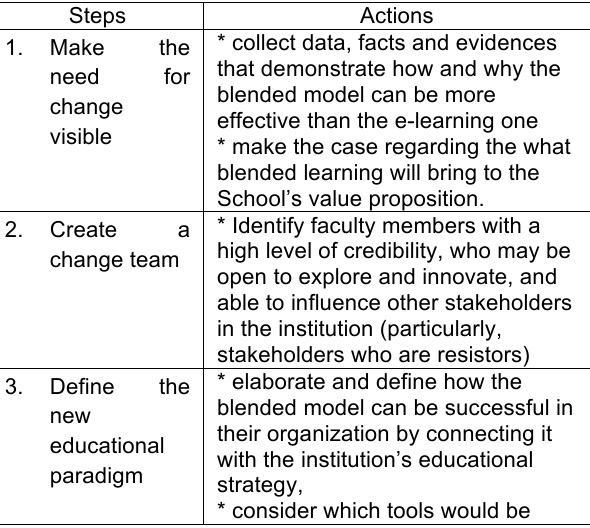
Table 2. Steps in the educational change framework